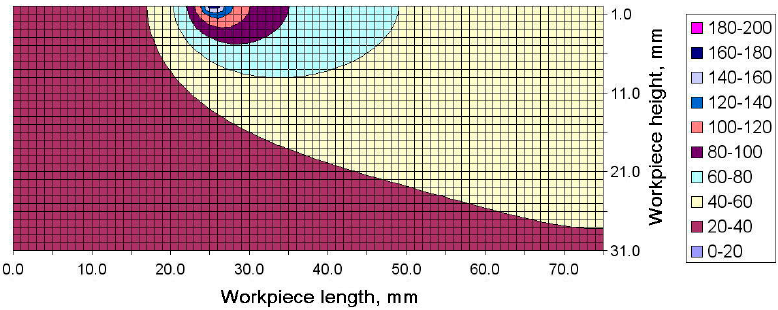
Figure 10. Temperature field for milling strategy 1 after ∆ t = 6.8 s.